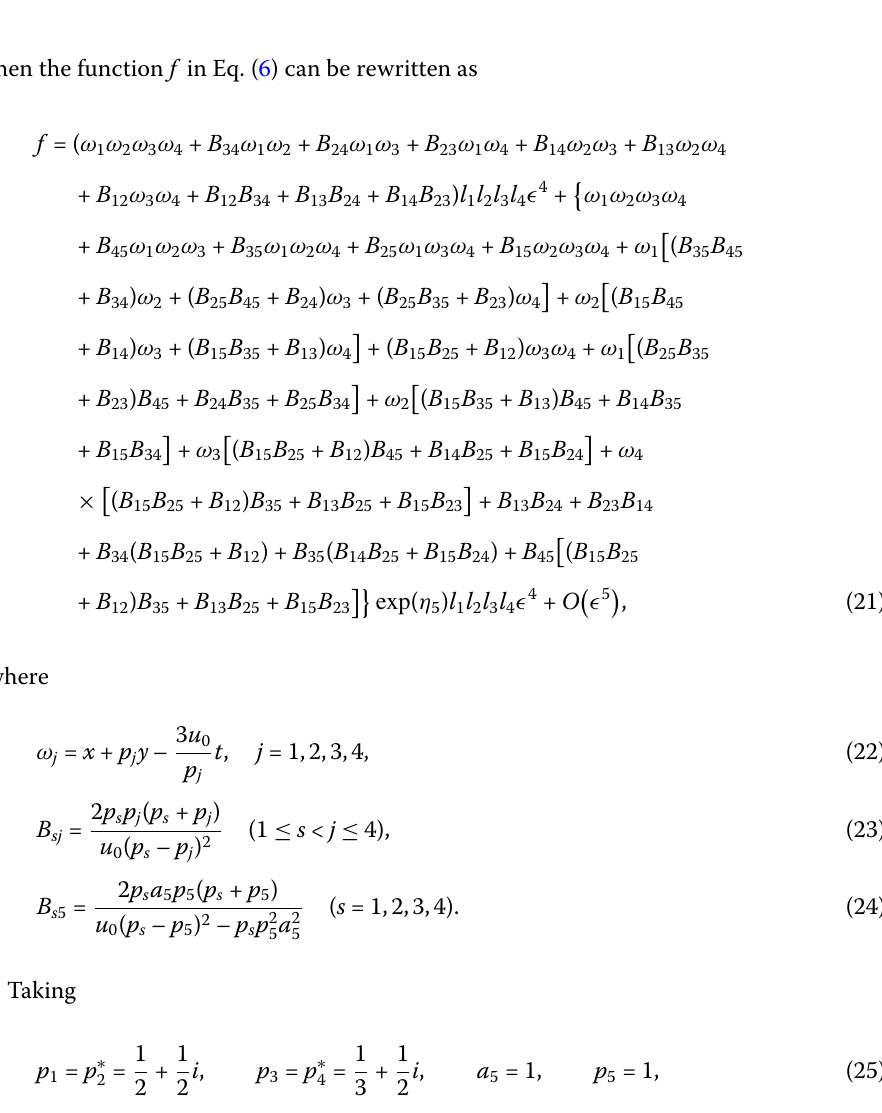
Table 1 Mixed interaction solutions from five-soliton N -soliton Mixed lump-soliton and lump-soliton-breather interaction solutions N =